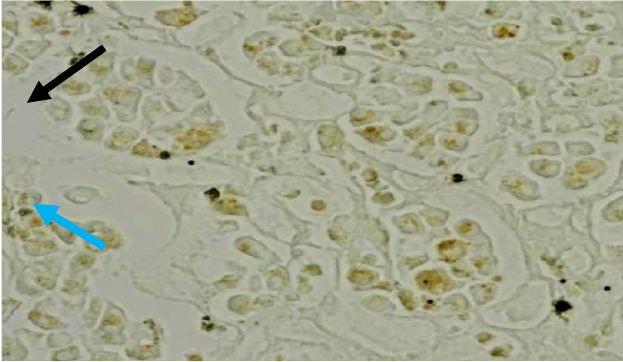
Figure 5. Histochemical section of medulla of squirrel adrenal gland showing adrenaline cells (black arrow) and noradrenaline cells (blue arrow). Potassium dichromate salts. H&E, 1000×